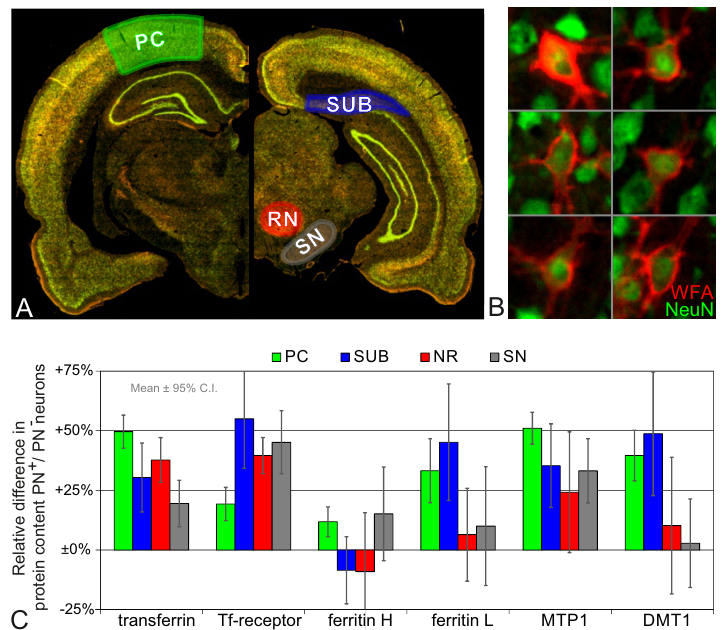
Figure 5. Slide-based cytometry. ( A ) Overview images of rat brain sections with triple-labelling for neurons (NeuN, Cy2 in green), PNs (WFA, Cy3 in orange), and selected iron proteins (Cy5, not shown). The ROIs selected for analysis are highlighted. ( B ) Sample of high resolution images of neurons from PC. The intense Cy3-WFA signal surrounding the NeuN-area (centred) identifies the neuron as PN + . ( C ) Ratio of averaged intracellular iron protein contents PN + to PN – from fluorescence intensity data. The dashed line marks the reference value 100% set by the values from PN – neurons. Data bars: Mean ± 95% confidence interval.